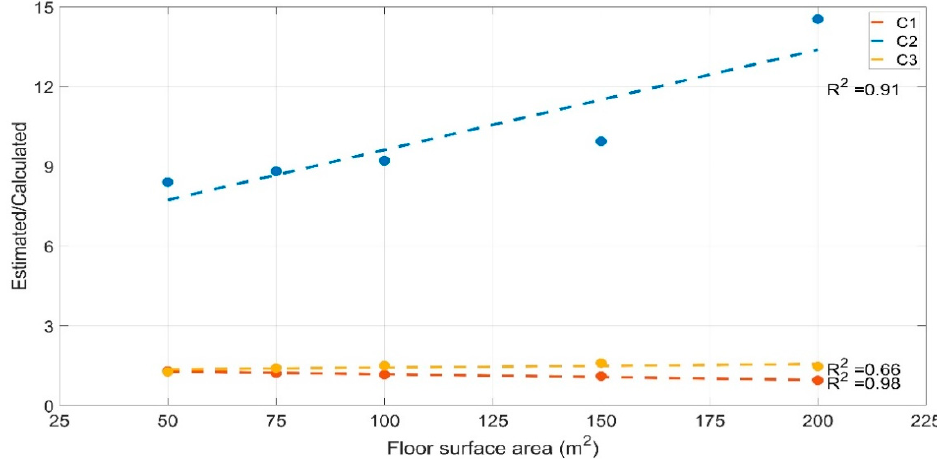
Figure 10. Estimated/calculated ratio of capacitances for different FS values in x-2-15-0 light-structured buildings.